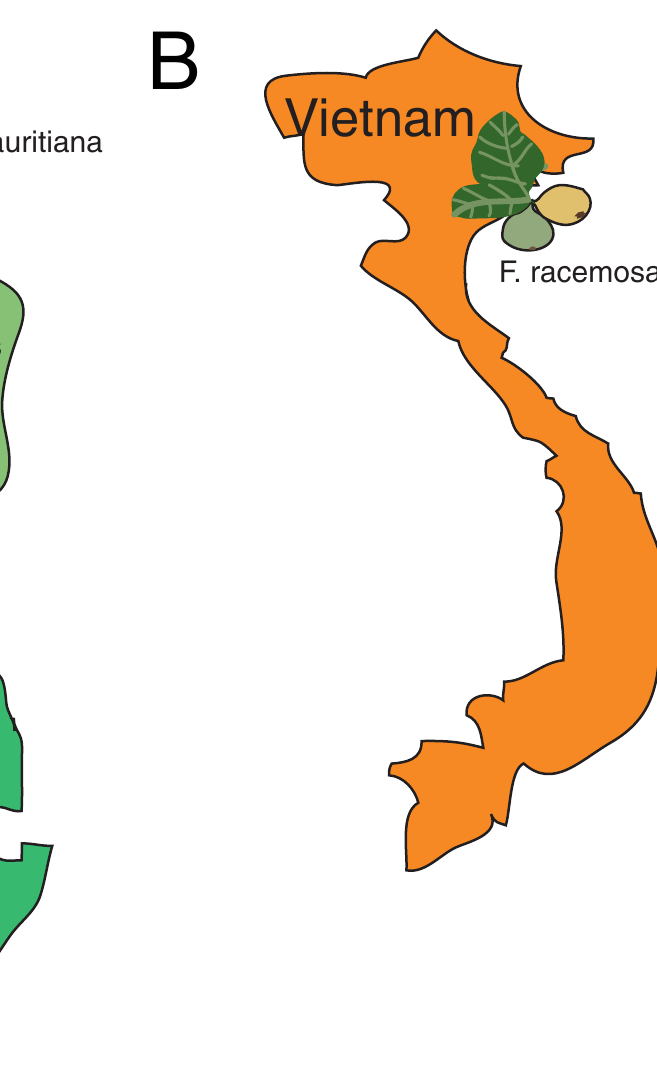
CGGYTACCTTGTTACGACTT-3’ ) [18]. Thermal cycling conditions were as follows: 3 min at 95˚C followed by 30 cycles of 15 s at 95˚C, 30 s at 55˚C, 1.5 min at 72˚C, and a final step of 8 min at 72˚C. A typical reaction contained 2 μl 10x PCR buffer, 2 μl 2 (cid:1) mmol (cid:1) l –1 dNTPs, 1μl of bacterial DNA. PCR amplicons were visualized by standard agarose gel electrophoresis [26]. All high quality 16S rRNA gene sequences of bacteria were classified by the SILVAngs webser- vice of the SILVA database [27].